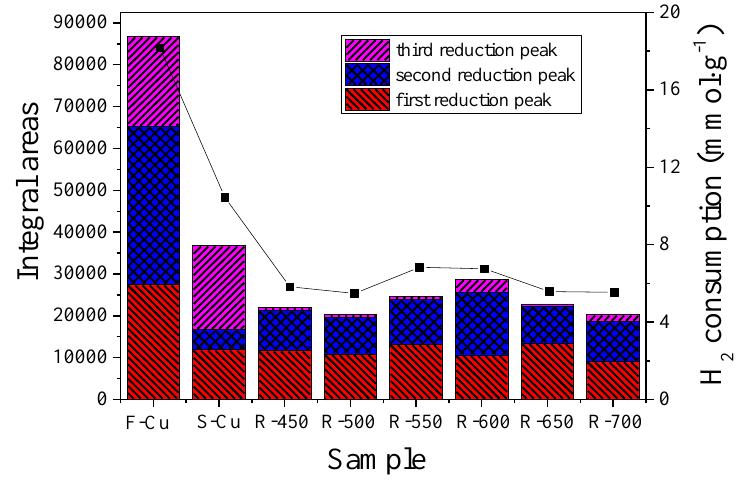
Figure 7. Cu species amount of catalysts and H 2 total consumption based on the H 2 -TPR analysis .